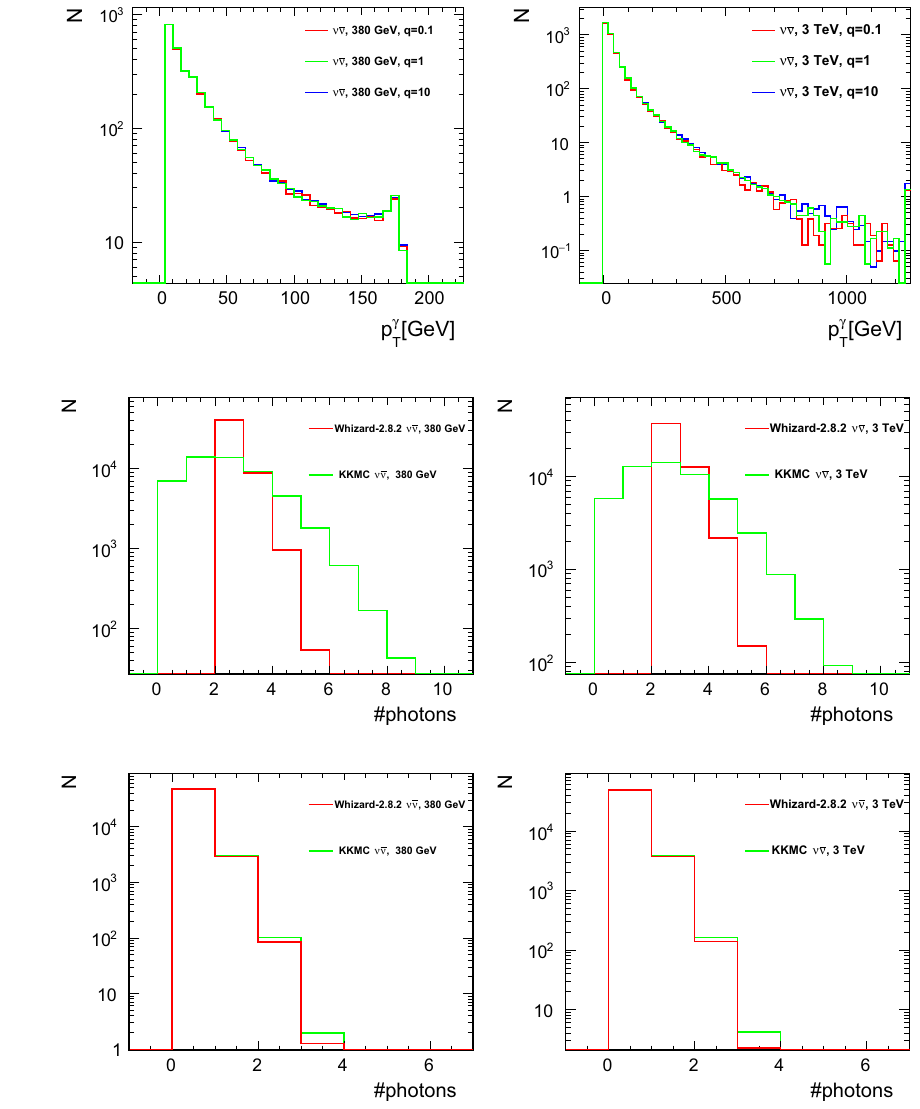
Fig. 5 Distributions of the number of photons in the neutrino pair production events generated by Whizard and the KK MC. Compared are multiplicities of all generated photons (upper row) and for those remaining after hard photon selection (lower row), for collision energy of 380GeV (left) and 3TeV (right). Distributions are normalised to the number of events expected for integrated luminosity of 1fb −